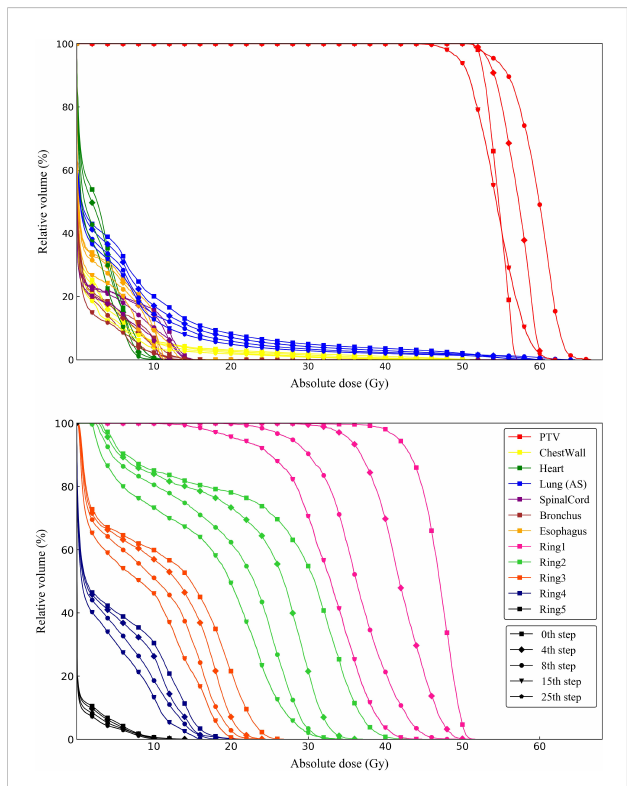
FIGURE 7 DVH curves of one representative case between 0th, 4th, 8th, 15th and 25th adjustment steps compared from ring structures and